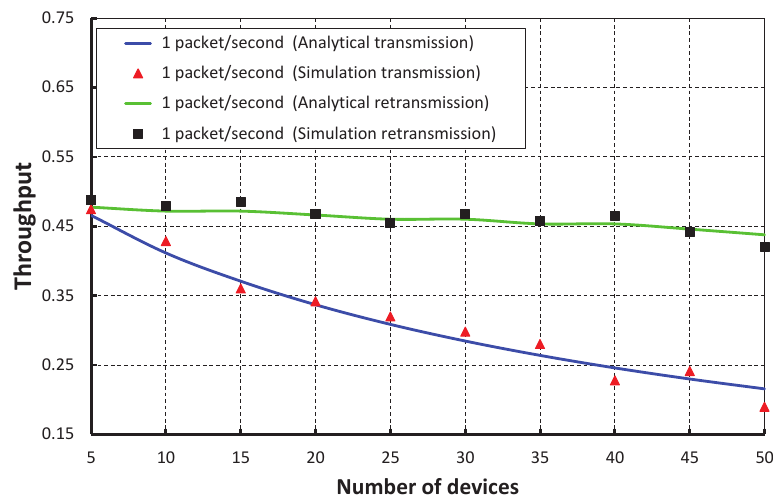
Figure 11. Validation of the throughput of our proposed scheme for different numbers of devices.